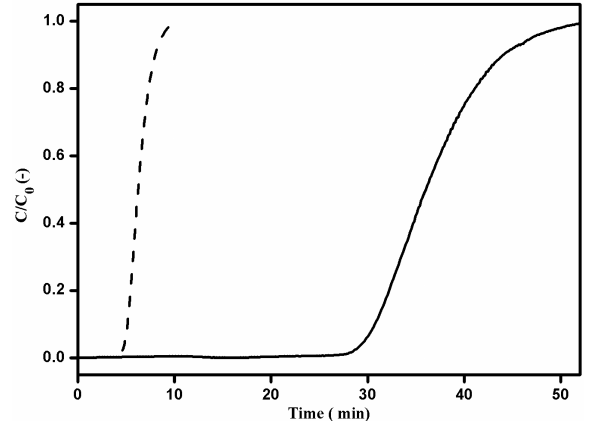
Figure 9. Breakthrough curves in terms of sample volume for (▬) BSA and (---) thyroglobulin on Q fibrous adsorbent packed in a column (5 mm ID × 5.5 cm L). Conditions: 20 mM phosphate buffer, pH 7.4, was used as the equilibration buffer, and the sample (2 mg/mL) was dissolved in running